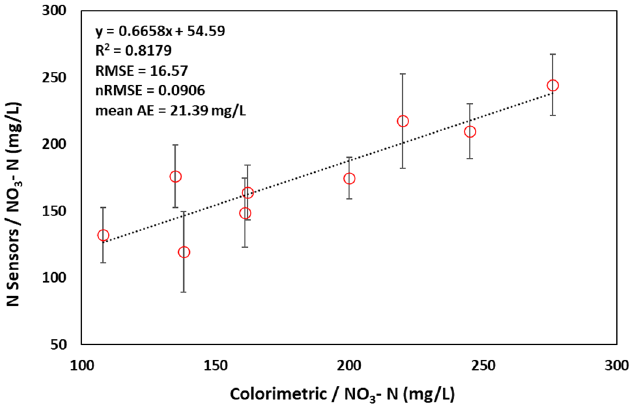
Figure 3. Correlation and regression between the nitrate levels measured by the soil N sensor and laboratory-based soil extraction and colorimetric analysis over a 3-month period. (See Table